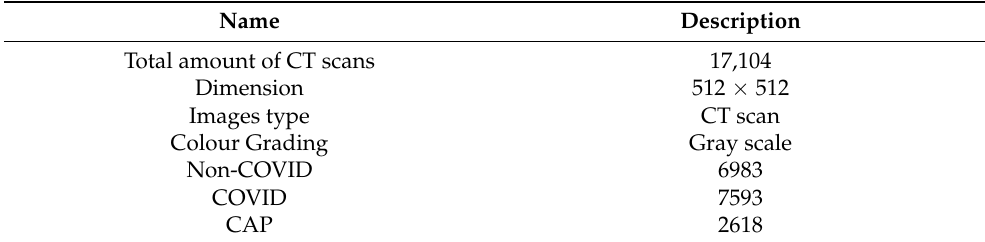
Table 1. Description of dataset.